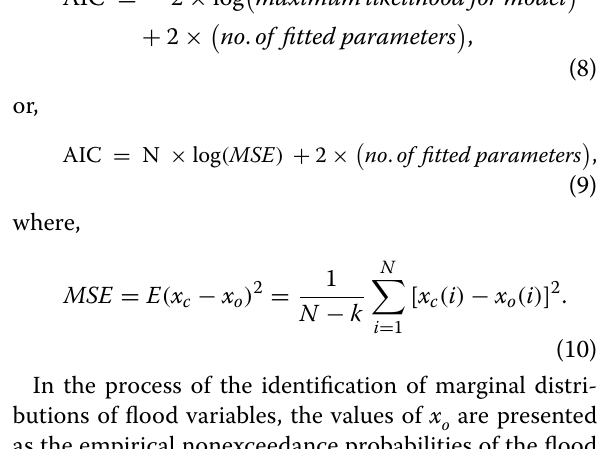
a D 1 is the first order Debye function, and for any positive integer k ,